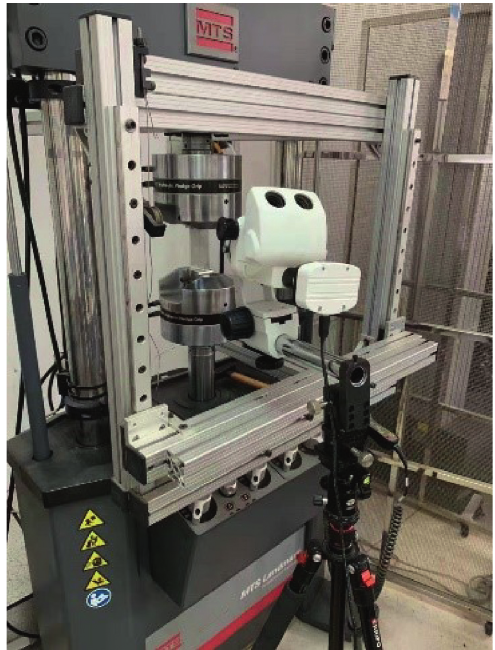
Figure 2: MTS fatigue testing machine system.